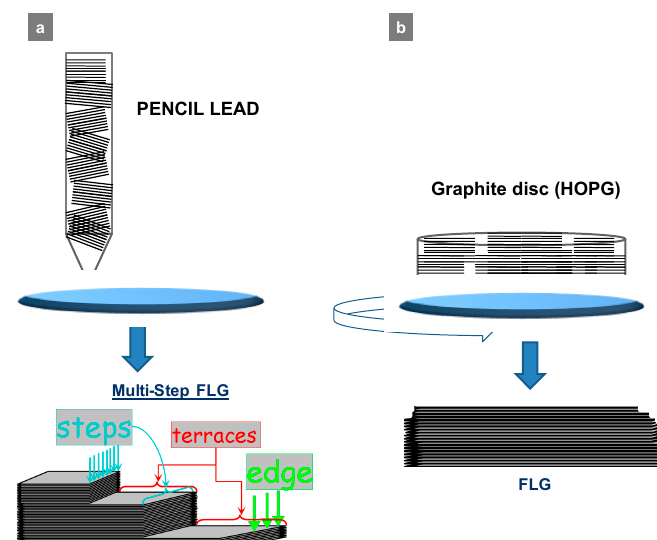
Figure 1. Draft of the ablation process over a rough glass surface ( a ) of a pencil lead and ( b ) of a graphite disc; related few-layer graphene (FLG) morphologies (lead-FLG with highly multi-step structure vs graphite-FLG). ChemEngineering 2019 , 3 , x FOR PEER REVIEW